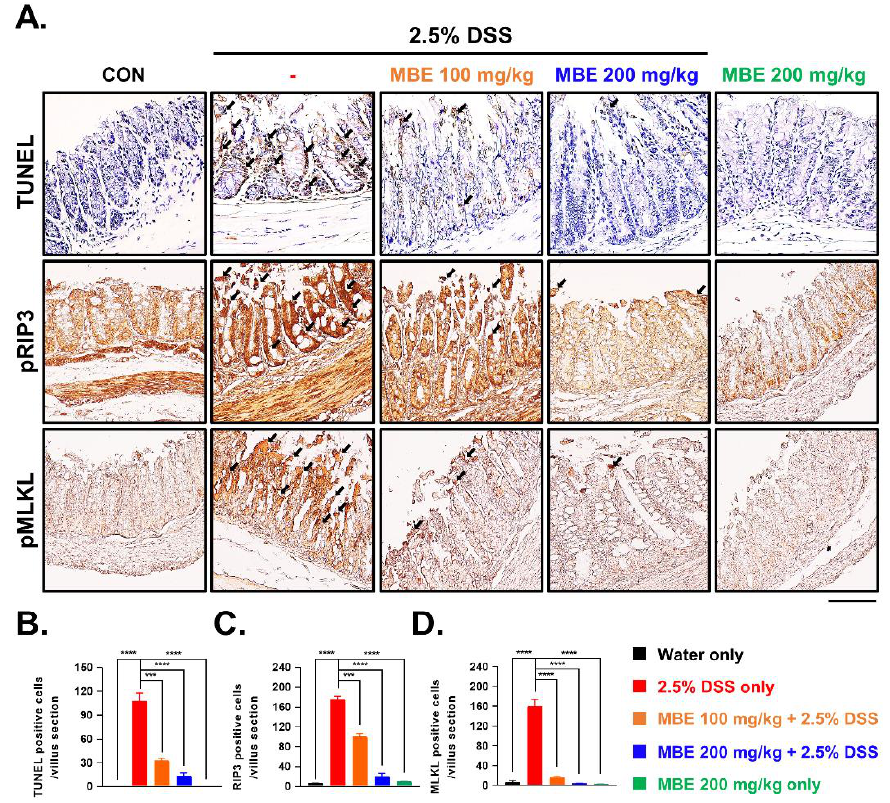
Figure 2. MBE ameliorates DSS-induced damage in the intestinal epithelium. ( A ) Large intestinal sections of mice were stained with TUNEL and pRIP3 and pMLKL antibodies. Colon tissues from mice on day 7 were analyzed using H&E staining and evaluated using histologic score analysis. Scale bar, 100 µm. TUNEL positive cells indicate cell death. Elevated pRIP3 and pMLKL indicate necroptosis. ( B – D ) The percentages of TUNEL-, pRIP3-, and pMLKL-positive cells were measured